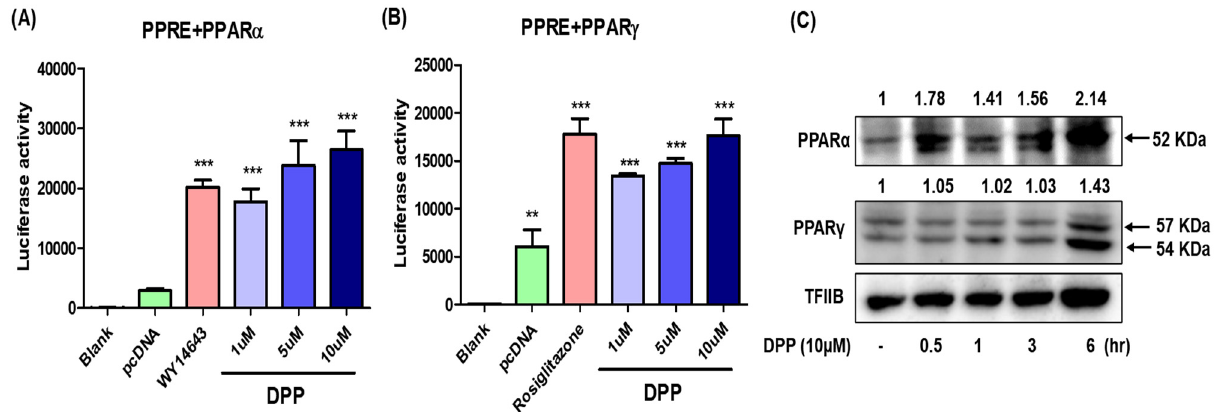
Figure 8. DPP increased transcriptional activity of PPAR α and PPAR γ . For luciferase, the 3 × PPRE-TK-LUC plasmid and PPAR α ( A ) or PPAR γ ( B ) expression vector were transfected into Ac2F cells. Twenty-four hours after the transfection, the cells were treated with DPP or agonists (WY14643 10 µM and Rosiglitazone 10 µM, respectively) for 5 h. Values are expressed as the mean ± SEM of two independent replications. ( C ) The nuclear levels of PPAR α and PPAR γ in Ac2F cells were analysed by western blot and band intensity were quantified by ImageJ program. Transcription factor II B (TFIIB) was used as loading control. Statistical results of one-factor ANOVA followed by the Bonferroni test: ** p <0.05 and *** p < 0.001 vs. blank.